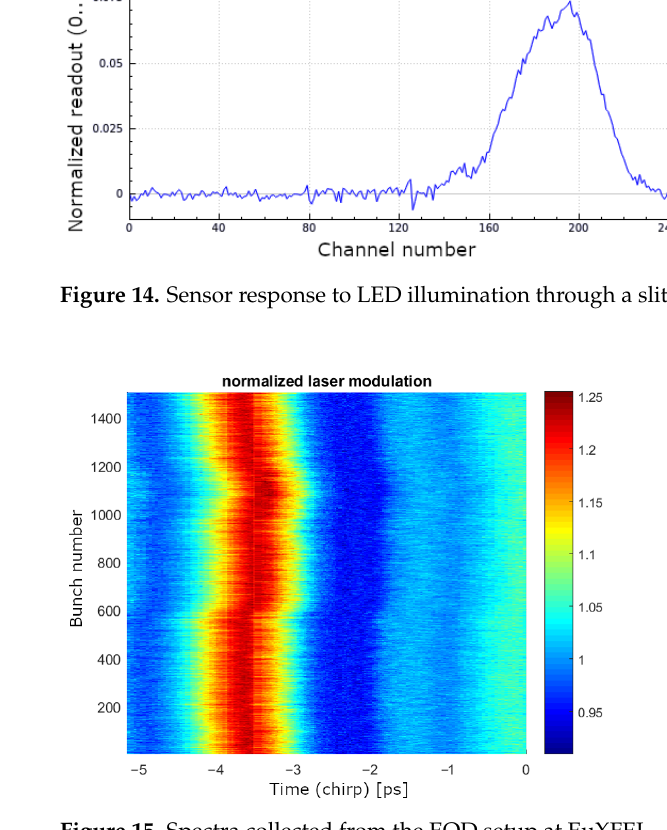
Figure 15. Spectra collected from the EOD setup at